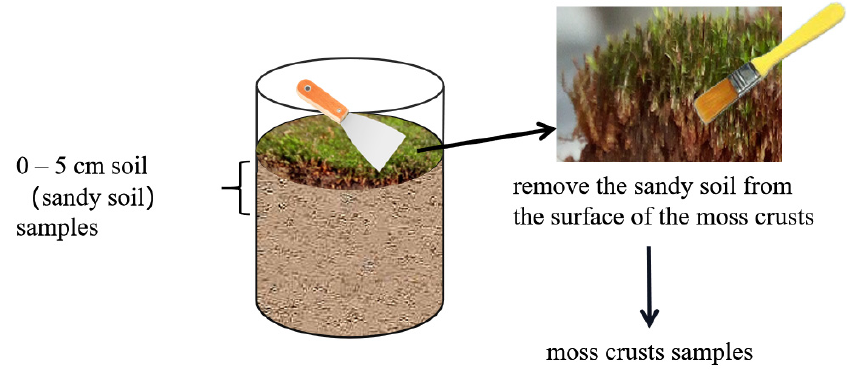
Figure 1. Schematic diagram of moss crust and soil sampling.